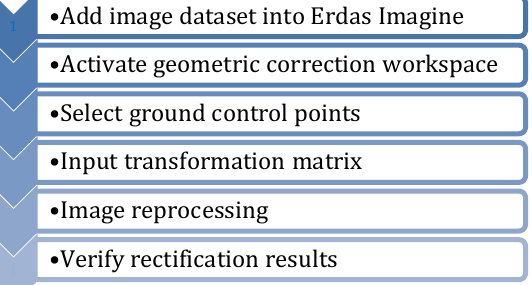
Figure 3. Workflow for image rectification using